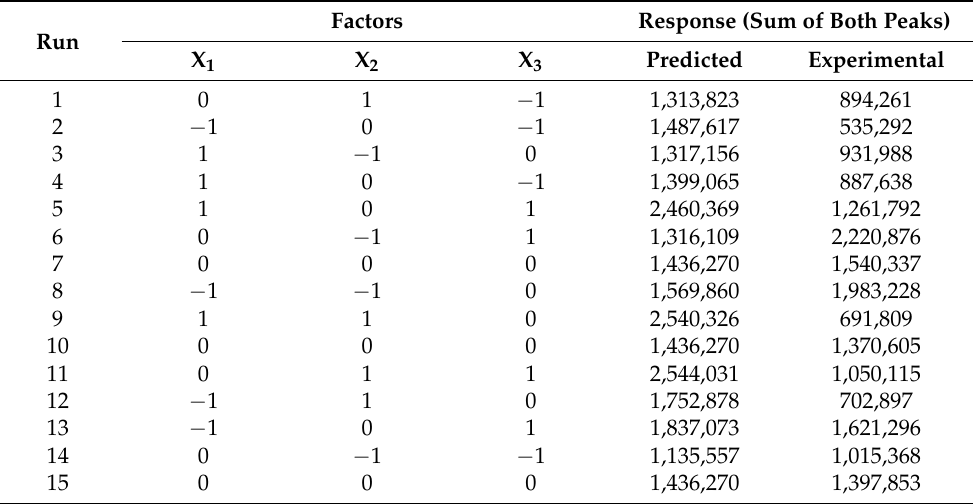
Table 1. Experimental and predicted values for absorbance based on the Box–Behnken design for microwave-assisted